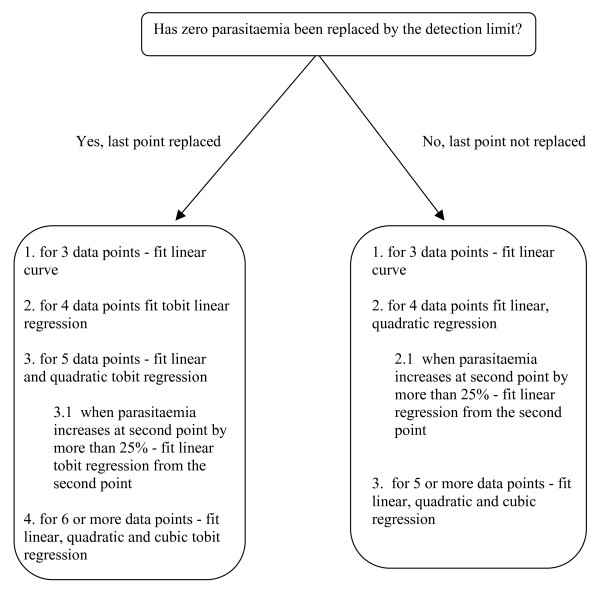
Flow chart showing the models tested during the process of finding the best model representing parasite clearance over time for an individual patient.